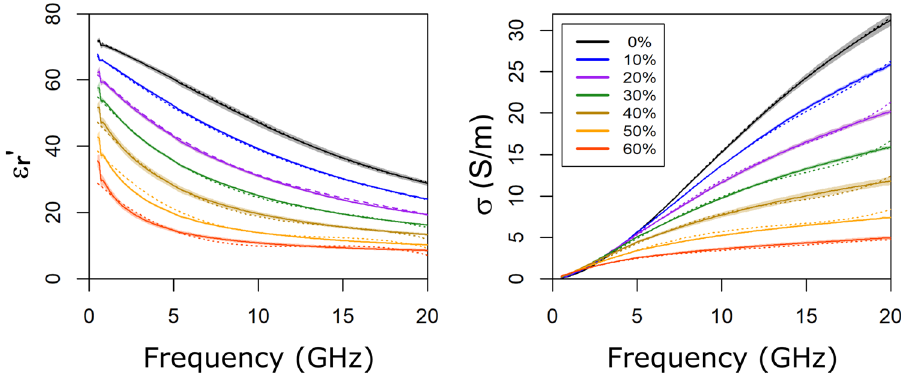
′ r ) and conductivity ( σ ) versus frequency,